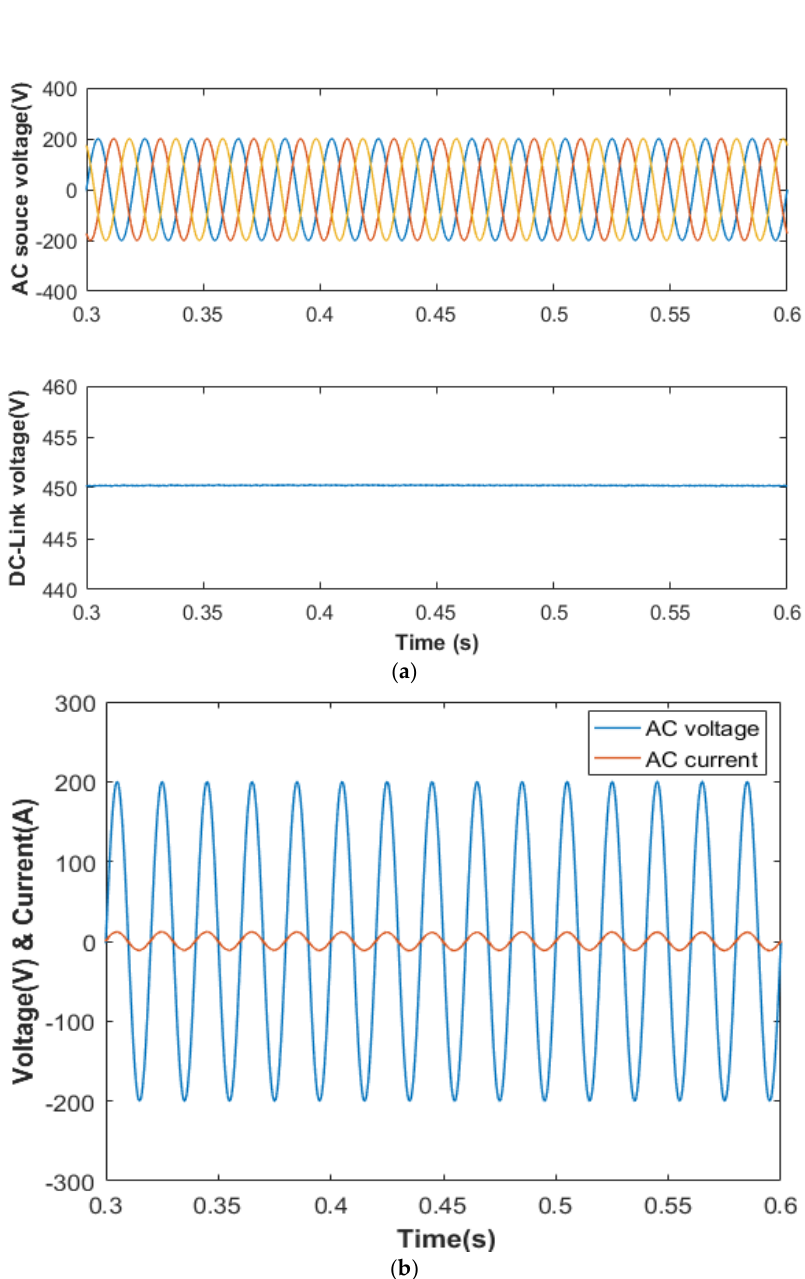
Figure 9. Simulation waveforms in parallel system with equal inductance and without ZSCC suppression strategy: ( a ) waveform of rectification (input, three-phase AC-source voltage; output, DC voltage); ( b ) A-phase voltage and current waveform of converter 1.